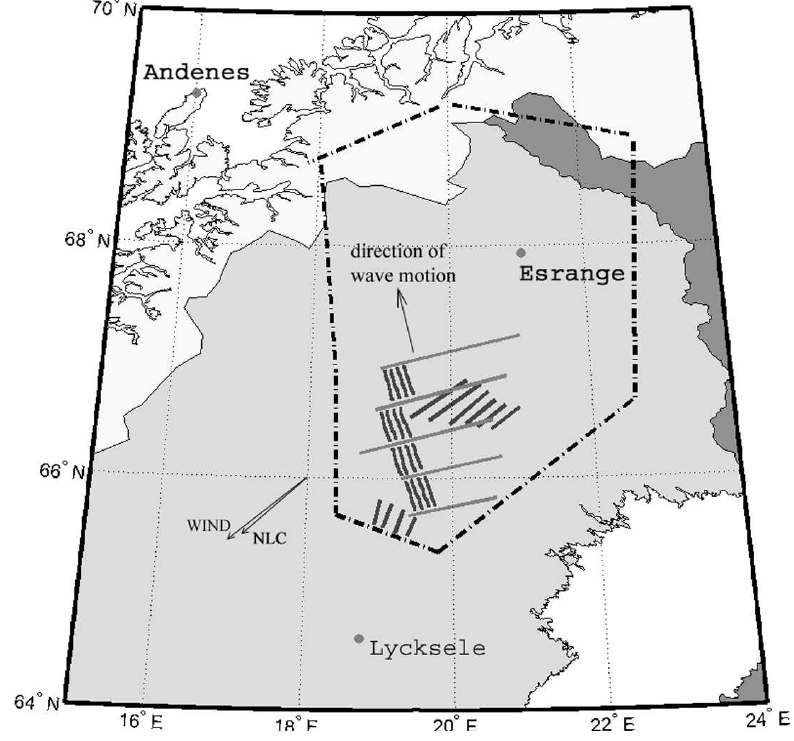
Fig. 2. Earth surface projection of the NLC area (dash) and observed waves of various scales (short and long lines).